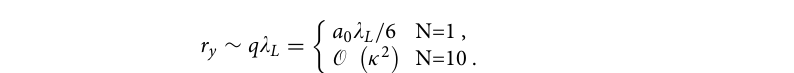
Figure 4. Maps of the electron density ( a ) and ( b ), electric field ( E y ) ( c ) and ( d ) and magnetic field ( B z ) ( e ) and 50 T L 1.65 ( f ) at t = ≃